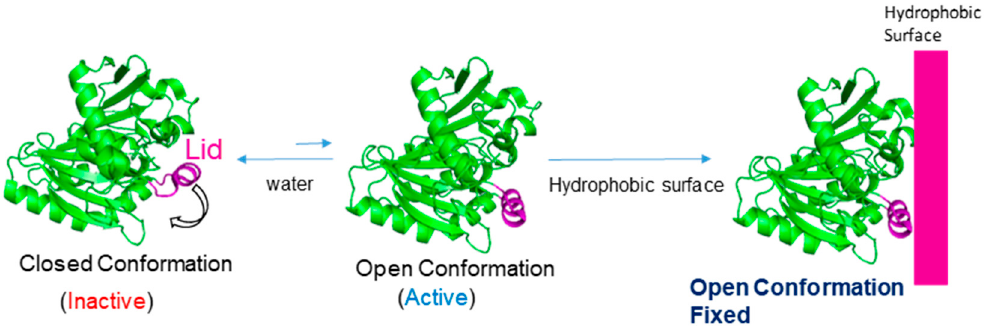
Figure 1. Mechanism and interaction of lipases with hydrophobic surfaces.